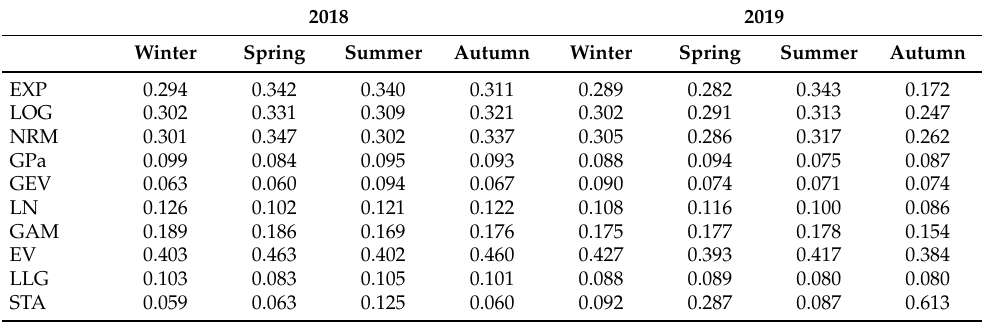
Table 5. KS-distances results for the Maximum Likelihood, and for the 2000 m